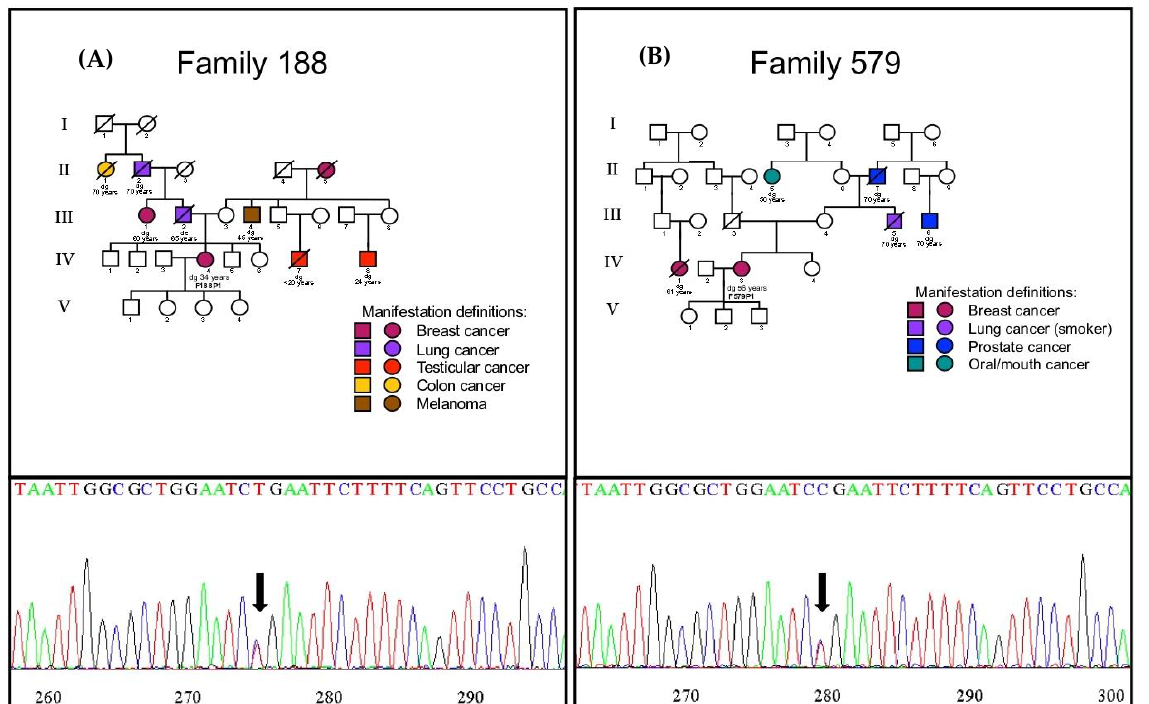
Figure 2. Pedigree and Sanger confirmation of rs144567652 heterozygous cases. ( A ) correspond to the pedigree of the F188 case (upper panel) and her Sanger confirmation (lower panel, arrow show the heterozygous variant). ( B ) correspond to the pedigree of the F579 case (upper panel) and her Sanger confirmation (lower panel, arrow show the heterozygous variant).